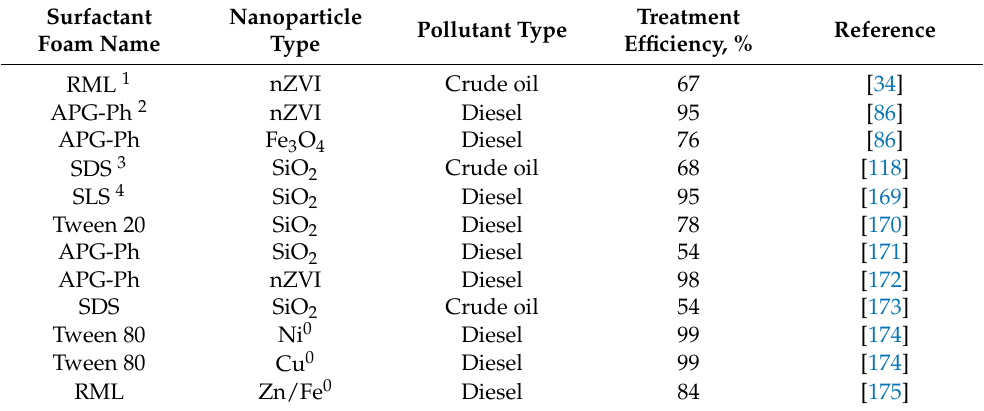
Table 5. Use of some surfactant foams and nanoparticles to remove oil pollutants from soil.